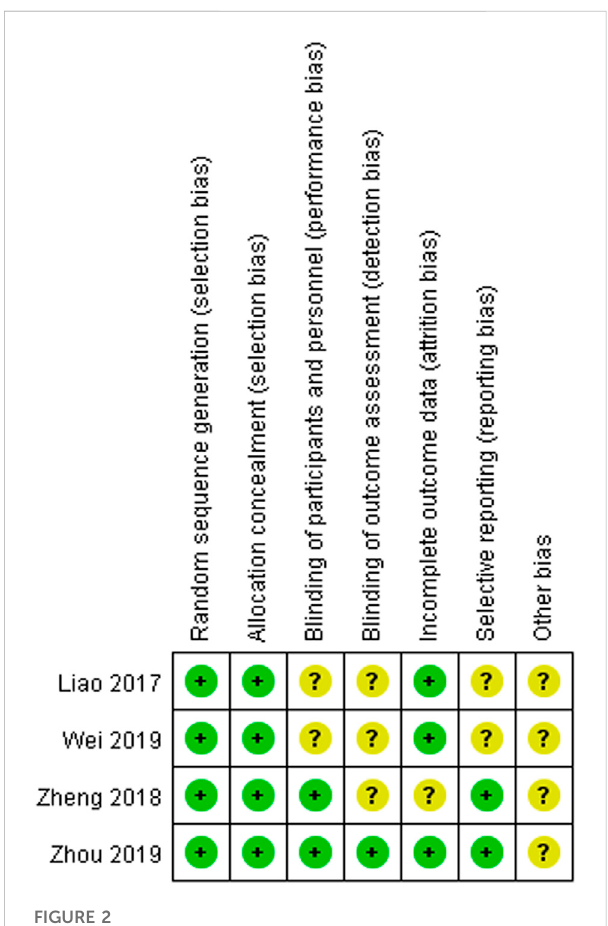
FIGURE 2 Bias assessment of randomized controlled trials.